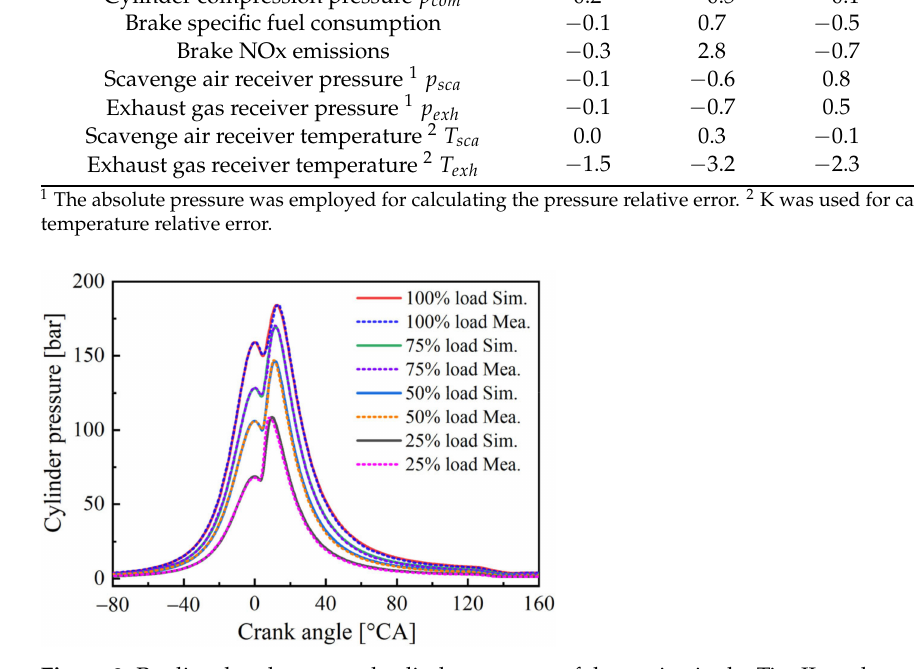
Figure 3. Predicted and measured cylinder pressure of the engine in the Tier II